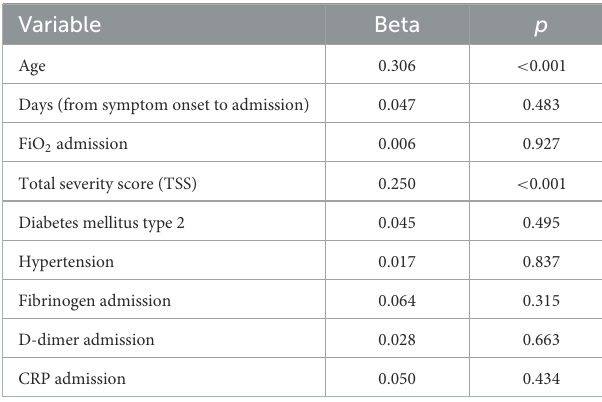
TABLE 2 Multiple linear regression model in the total population for days of